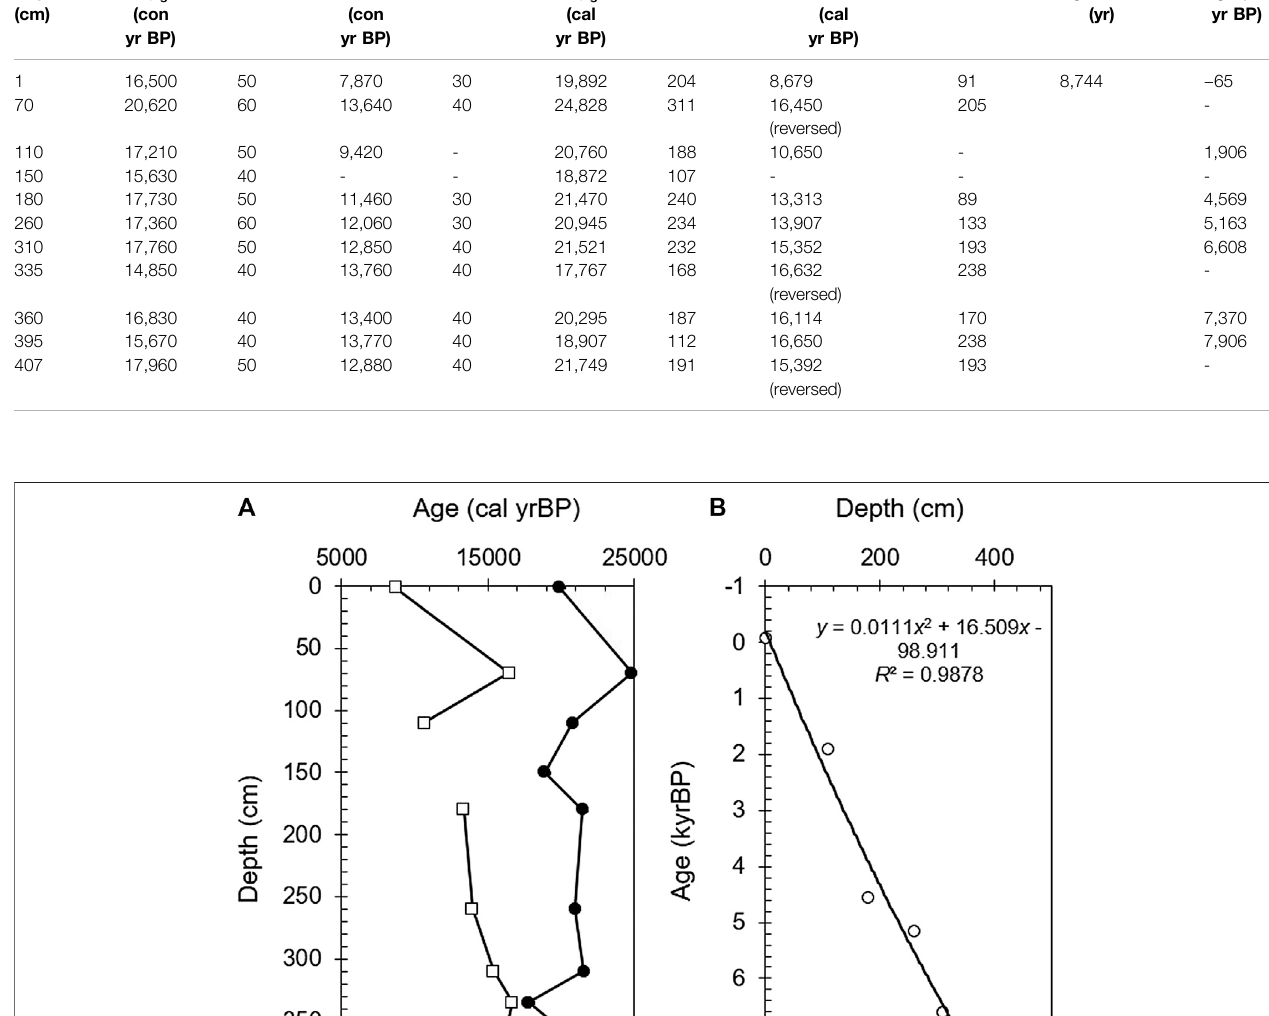
Frontiers in Earth Science |